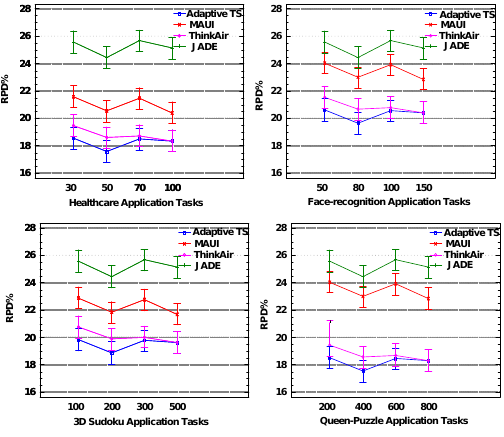
Figure 6. Application Response Time